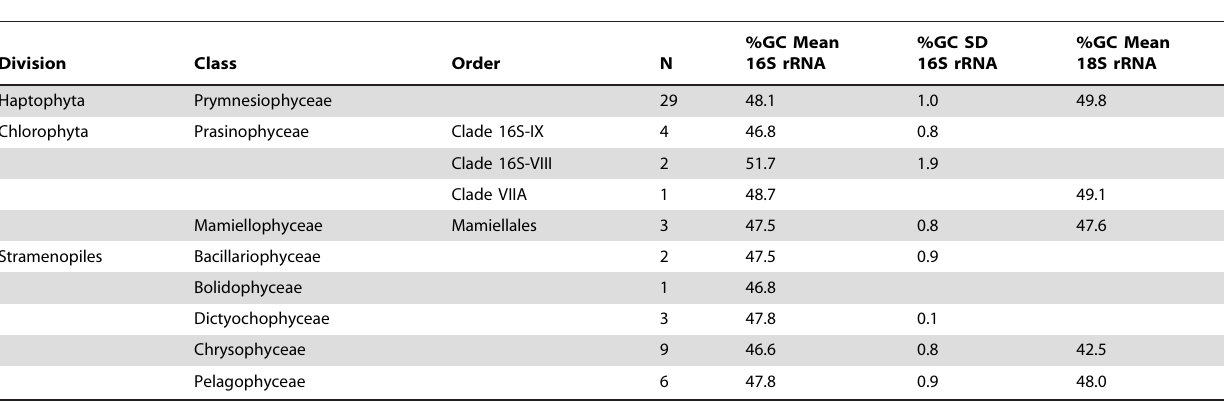
Table 3. %GC content (Mean and SD) of the partial plastid 16S rRNA gene sequences for the different phylogenetic groups